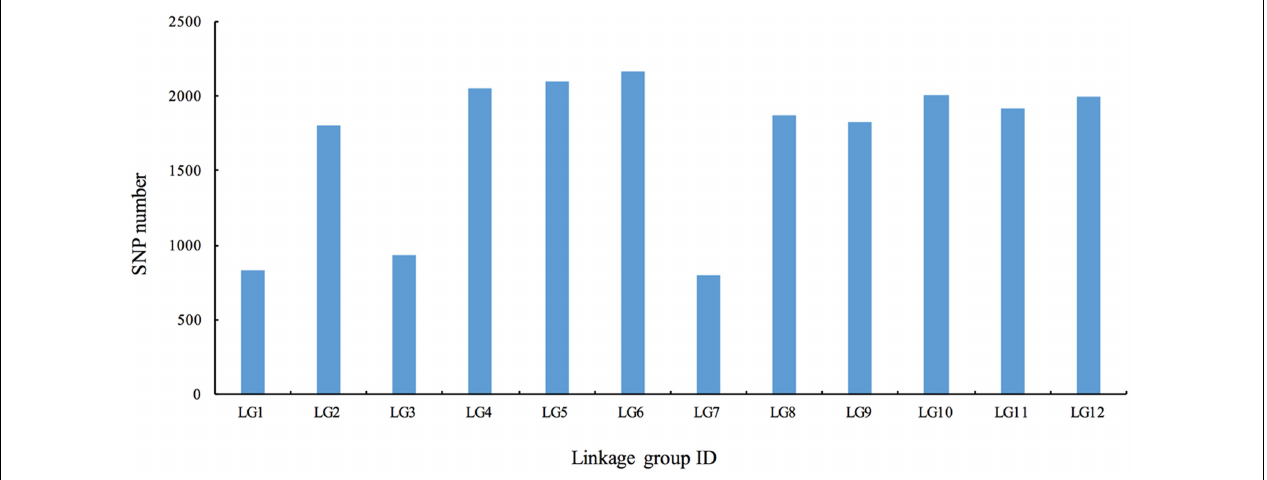
FIGURE 3 | The number of single nucleotide polymorphism (SNP) markers on the each of the linkage group.